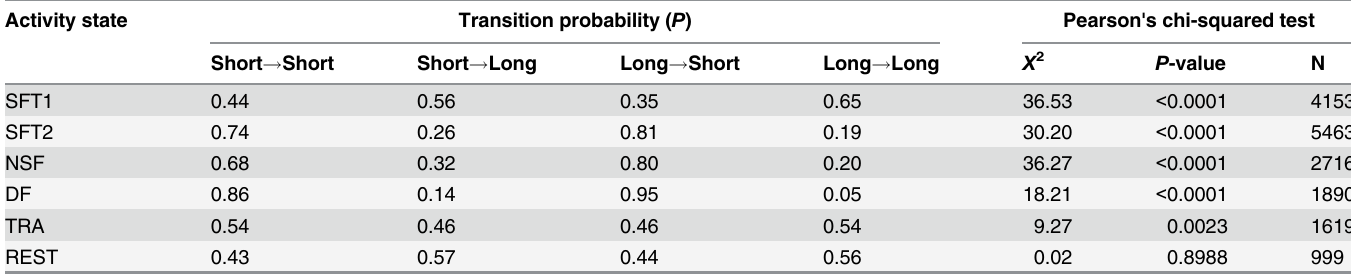
Table 3. Transition probabilities between dive types of minke whales for different activity states and test statistics from the Pearson ’ s chi-squared tests. Activity state